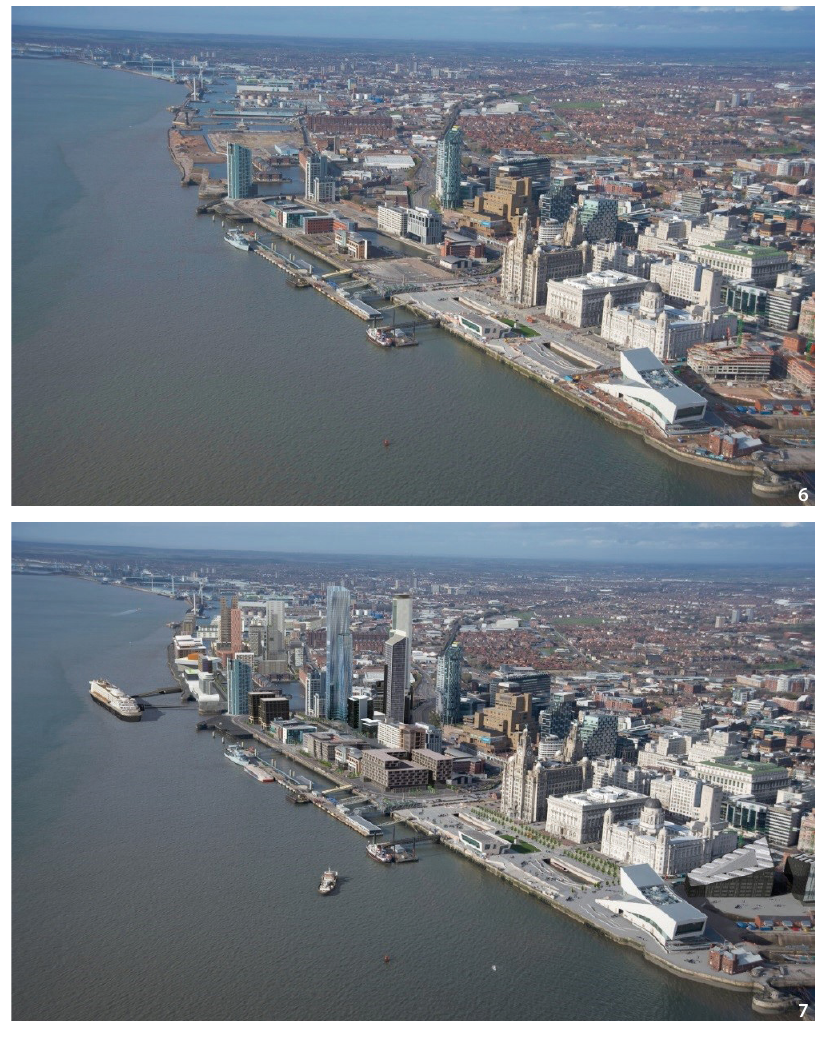
Figure 6 Liverpool Maritime Mercantile City, 2009: Aerial view of the Pier Head group look- ing northwards across the site of Liverpool Waters (Source: www.ruststudios.co.uk). Figure 7 Liverpool Maritime Mercantile City: A 2014 visualisation of the same view show- ing the proposed development of Liverpool Waters (Source: